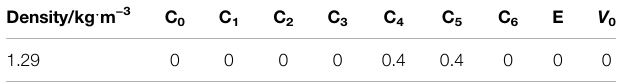
TABLE 2 | Air material parameters.